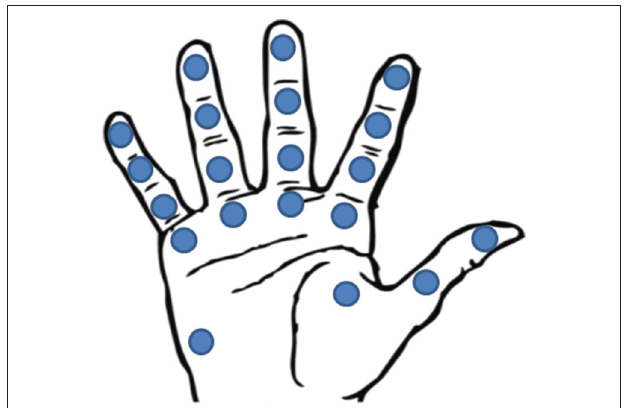
FIGURE 4 | Location of the 20 FSR sensors in Kargov et al.